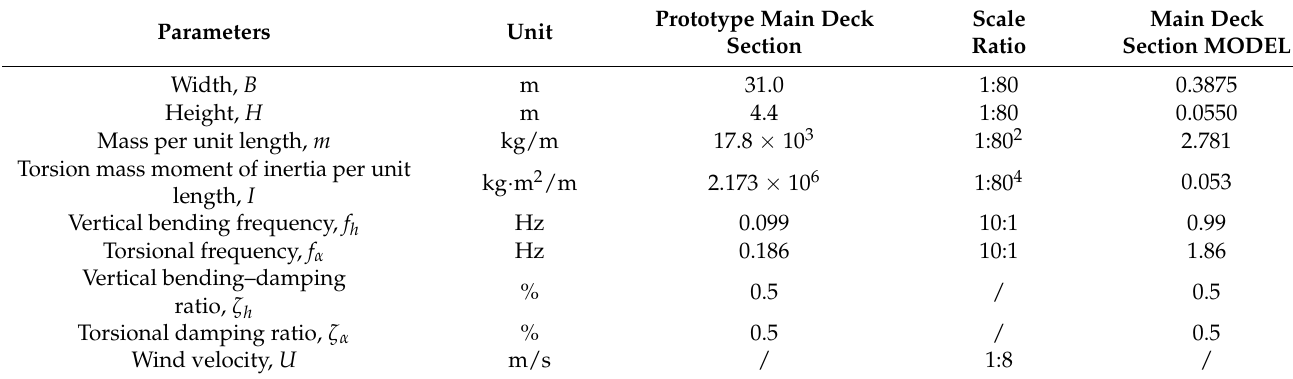
Table 3. Main parameters of the main deck section of GBEB.